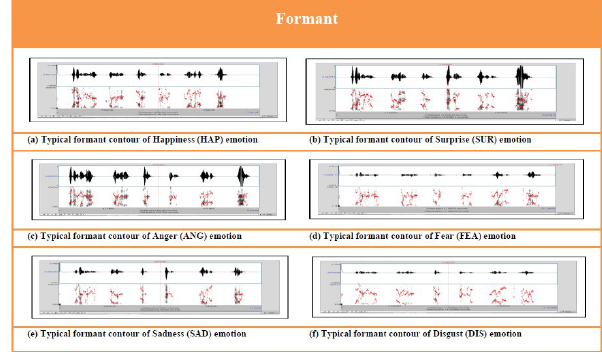
Fig.13. Europeanspeakerstypicalformantcontourofbasicemotions.